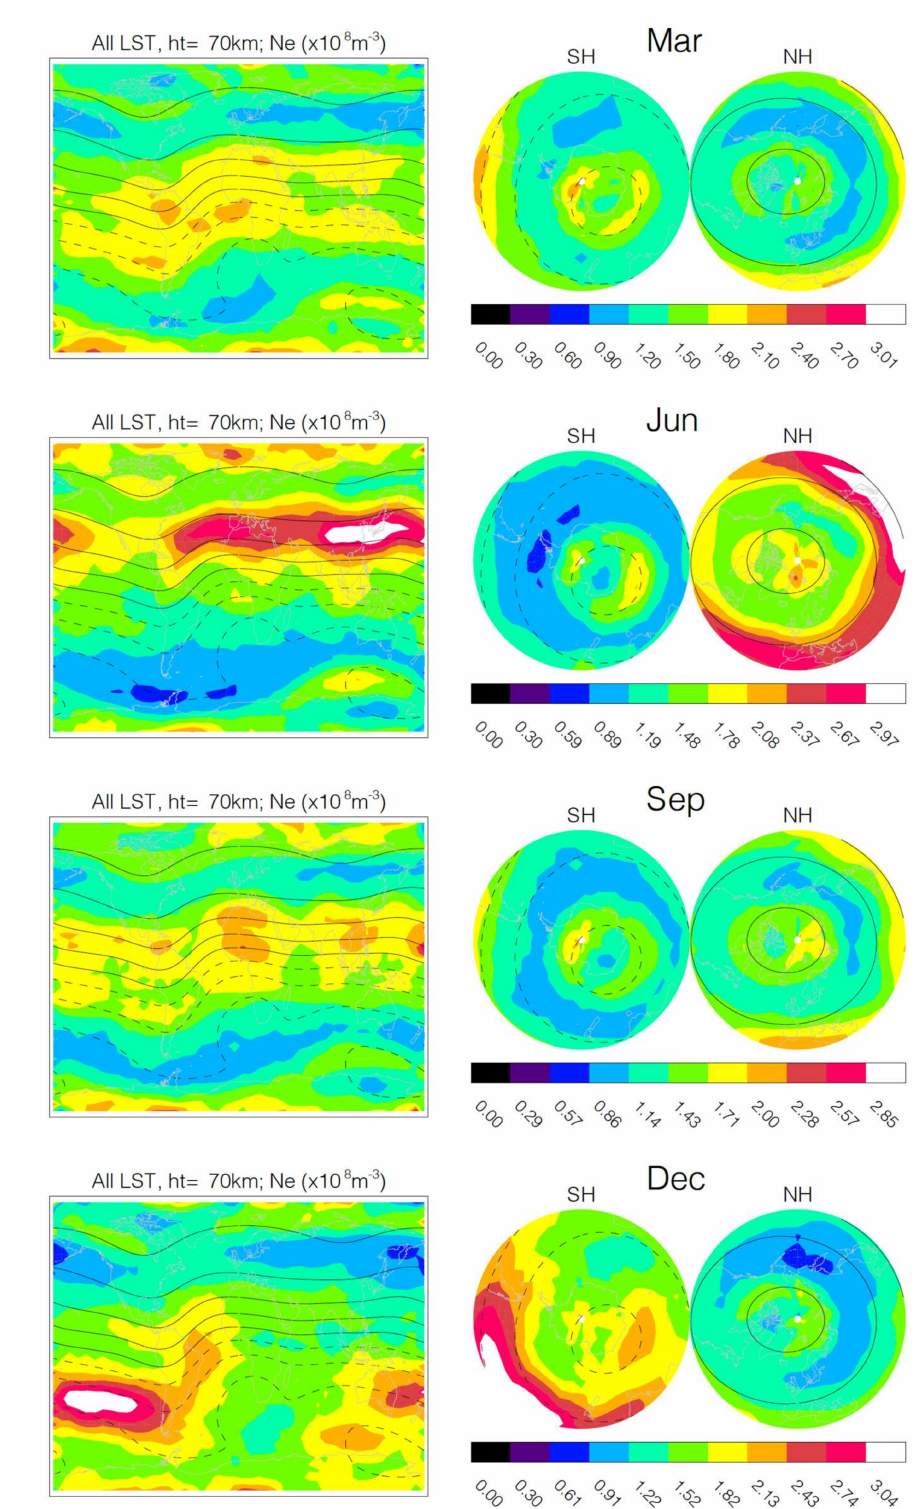
Figure 10. COSMIC-1 monthly N e maps at 70 km from all local times for March, June, September, and December. Magnetic field-line pitch angles (a.k.a., dip angles) are contoured at an interval of 20 ◦ . The pitch angles on the cylindrical-projection map ( left ) are derived from the magnetic field at a 100 km altitude, whereas the ones on the azimuthal polar maps are from the field at one Earth radius above the surface. The longitude–latitude grid size is 8 ◦ × 4 ◦ for these